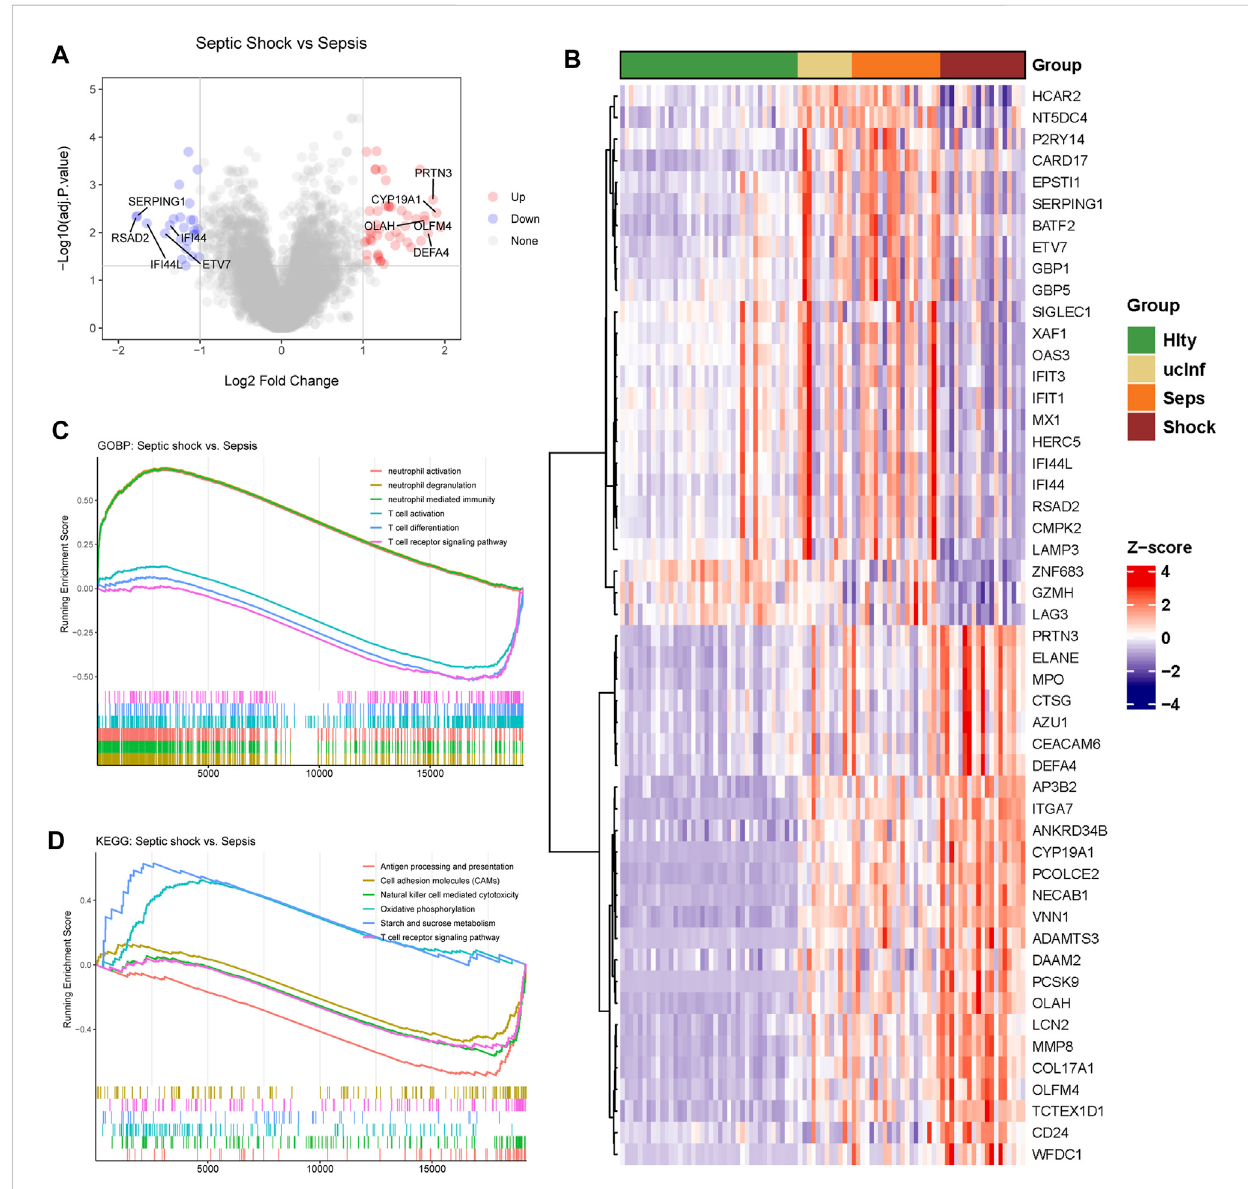
Differential gene expression between septic shock and sepsis patients. (A) Differently expressed genes in septic shock (n = 19) vs. sepsis (n = 20) group. (B) The expression heatmap of 25 top upregulated DEGs and 25 top downregulated DEGs. Hlty, healthy control; ucInf, uncomplicated infection; Seps, sepsis; Shock, septic shock. (C) Biological processes enriched in septic shock vs sepsis groups. (D) KEGG pathways enriched in septic shock vs. sepsis